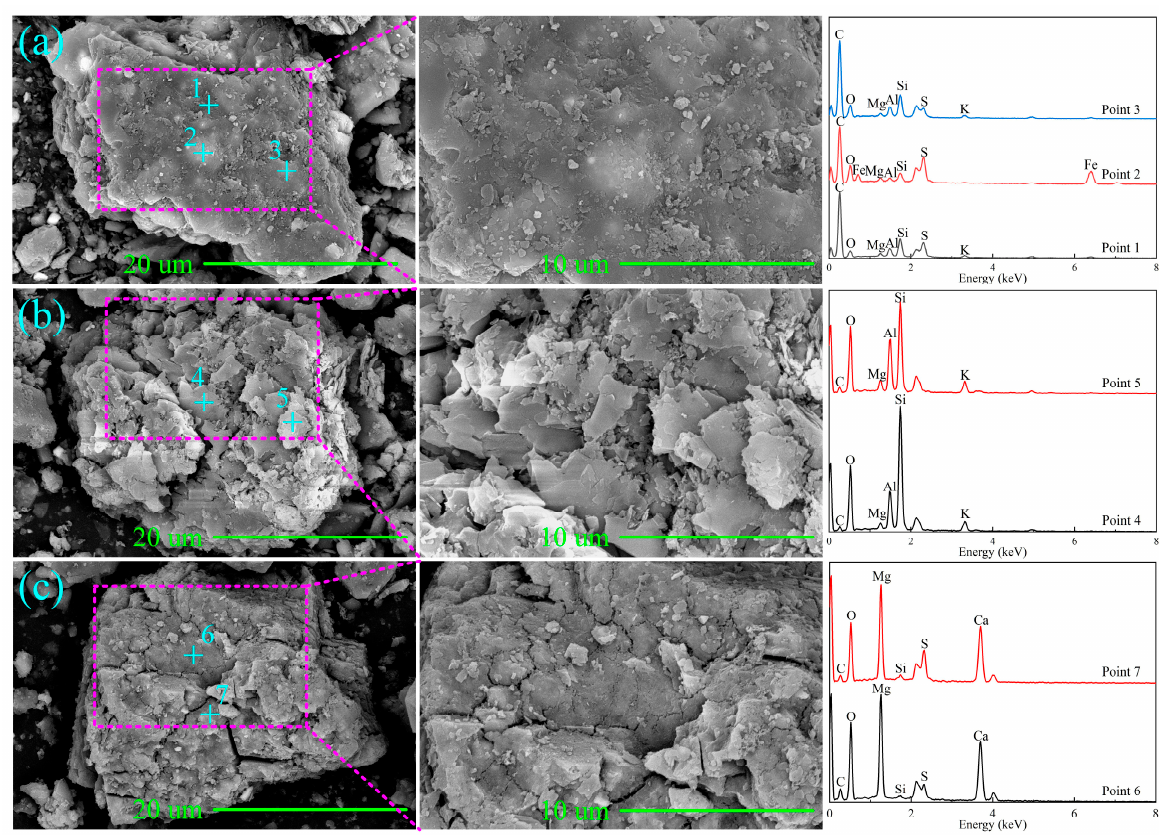
Figure 13. SEM images and EDS results of the raw ore ( a ) and the product roasted under optimal conditions ( b , c ).